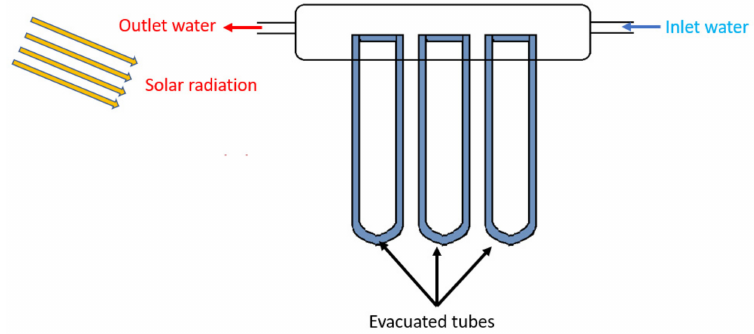
Figure 3. Schematic diagram of an all-glass evacuated tube solar water heater.